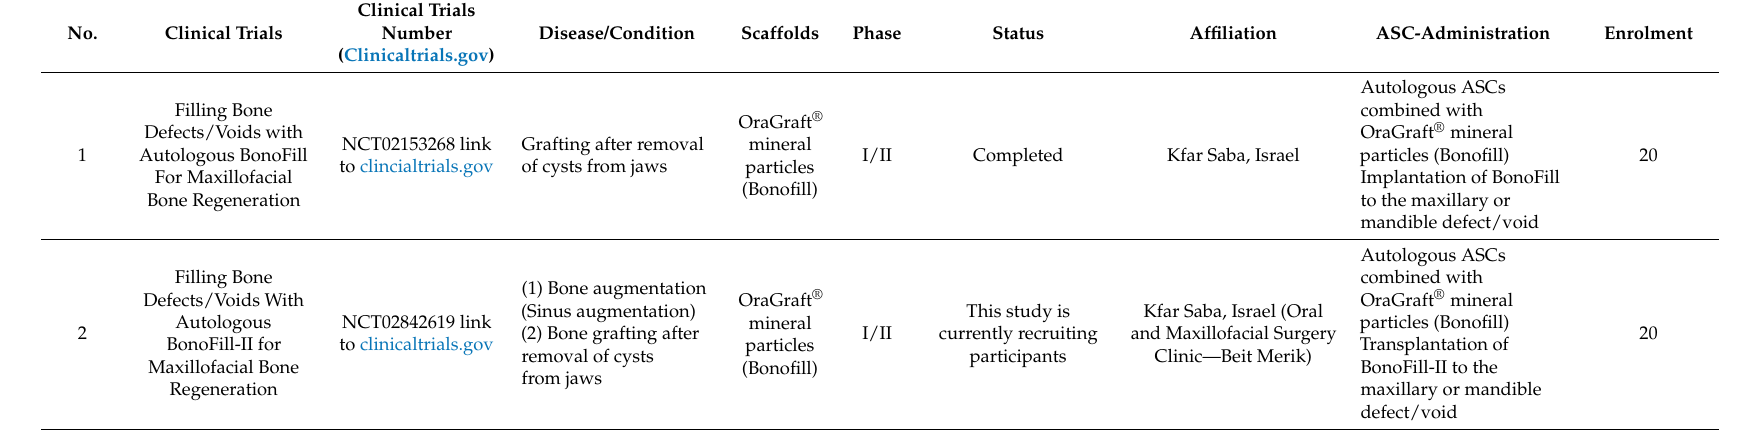
Table 2. Registered Therapeutic Clinical Trials Using ASCs to Repair Maxillofacial Bone Defects